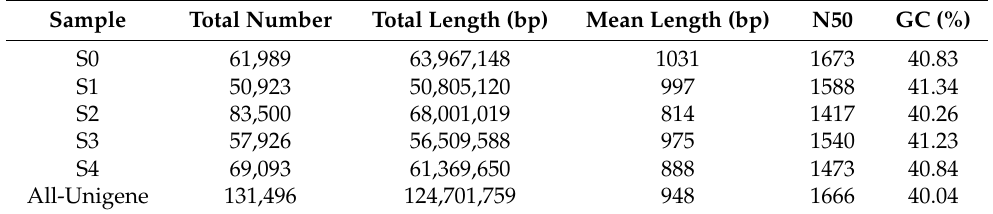
Table 1. Summary of Illumina transcriptome sequencing for different periods of somatic embryogenesis.